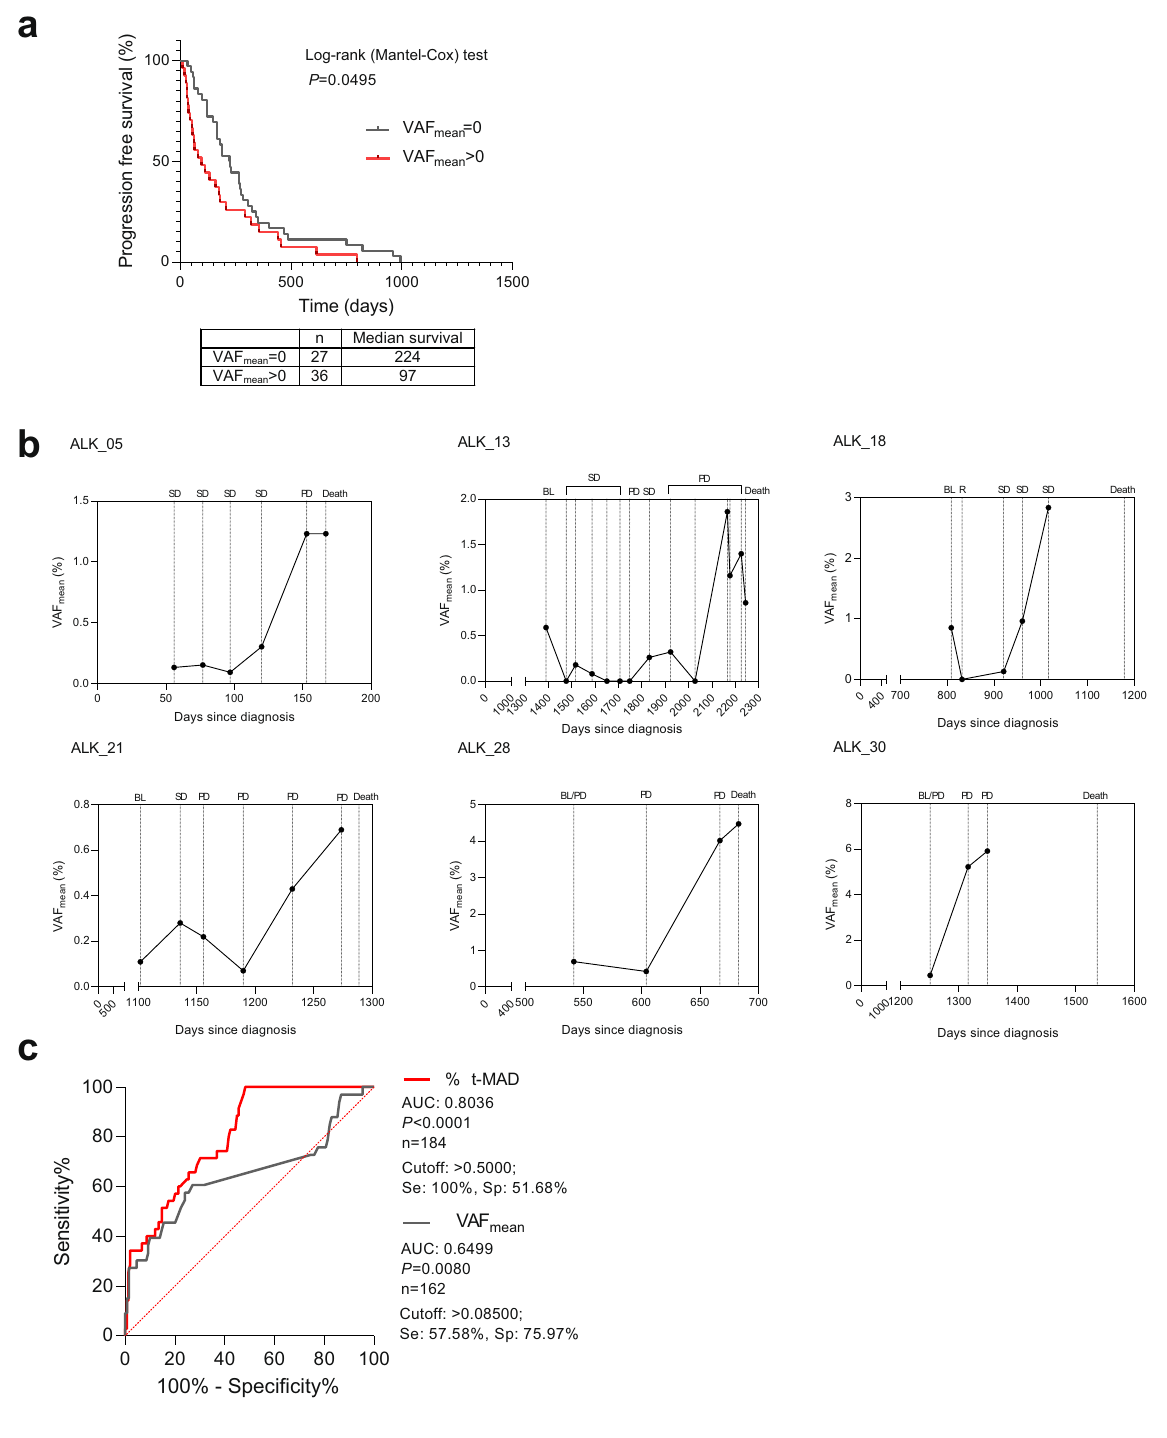
Fig. 2 Prognostic utility of ctDNA NGS assays. a Mean variant allele frequency at baseline indicates therapy durability. Progression-free survival plot showing signi fi cantly longer therapy durability in instances when ctDNA is undetected (VAF mean = 0) compared to detection (VAF mean > 0) at treatment initiation. b VAF kinetics in representative patients showing elevated VAF mean towards end of life. SD stable disease, PD progressive disease, BL therapy baseline, R response. c Comparison of receiver operating characteristic curves (ROC) using Δ VAF mean (gray) or % Δ t-MAD (red) in discriminating progressive and non-progressive disease